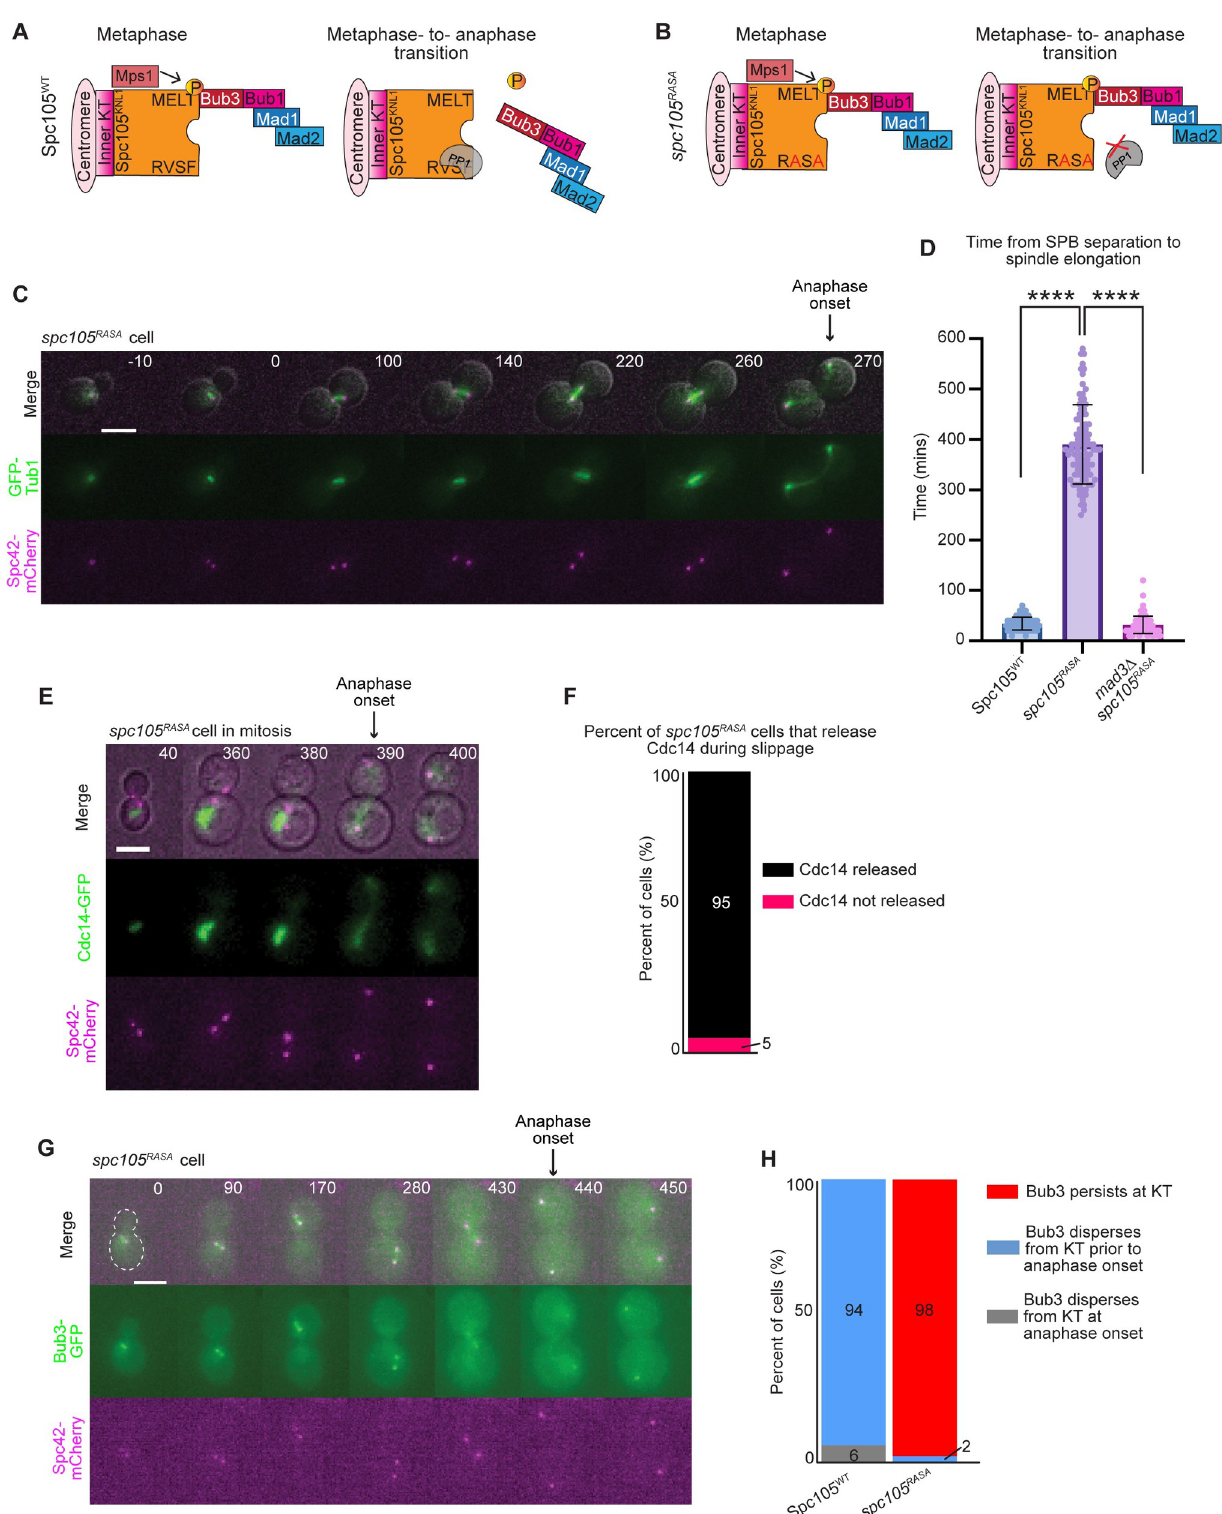
Fig 5. Mitotic slippage occurs in spc105 RASA mitosis. A) Cartoon representation of Spc105 WT in metaphase (left) and at the metaphase-to-anaphase transition (right). To signal the spindle checkpoint, Mps1 phosphorylates Spc105 for binding of spindle checkpoint proteins at the kinetochore. At the metaphase-to-anaphase transition, PP1 binds Spc105 at the RVSF motif to dephosphorylate Spc105 and silence the spindle checkpoint. B) Cartoon